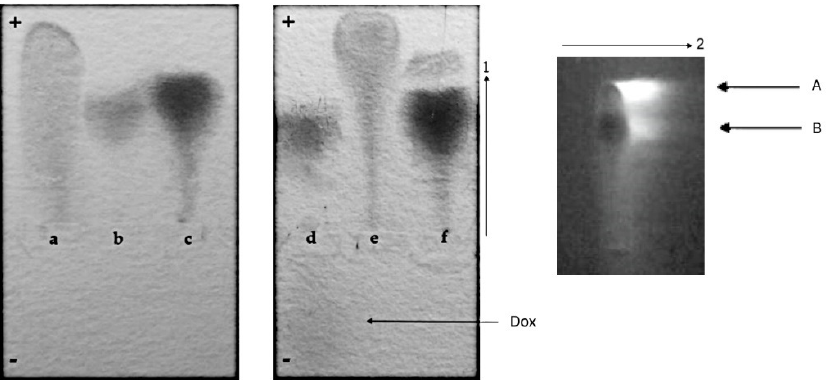
Figure 4. Complexes between BSA and CR-Dox (2:1)—replica on filter paper applied to bromophenol blue-stained gel (after agarose gel electrophoresis at pH 8.6); migration towards the anode (+): ( a ) CR, ( b ) BSA, ( c ) BSA-CR complex, ( d ) BSA and Dox (Dox can be seen as migrating towards the cathode (-), pointed by arrow), ( e ) CR-Dox complex, ( f ) BSA-CR-Dox (2:1) complex. The presence of Dox in the complex (BSA-CR-Dox) was confirmed chromatographically. The separation of CR-DOX mixtures was performed by Whatman 3 paper chromatography in butanol:acetic acid:water (5:1:4) solvent. Dox is seen as bright-orange fluorescence. For semiquantitative evaluation, DOX was eluted and the fluorescence was measured (emission signal at 550 nm upon excitation with a 470 nm laser beam) (the picture on the right; arrow no. 1 shows the direction of electrophoresis, and arrow 2 the direction of chromatography)—arrow ( A ) points to Dox released during chromatography from its complex with CR, while arrow ( B ) points to Dox released from the BSA-CR-Dox